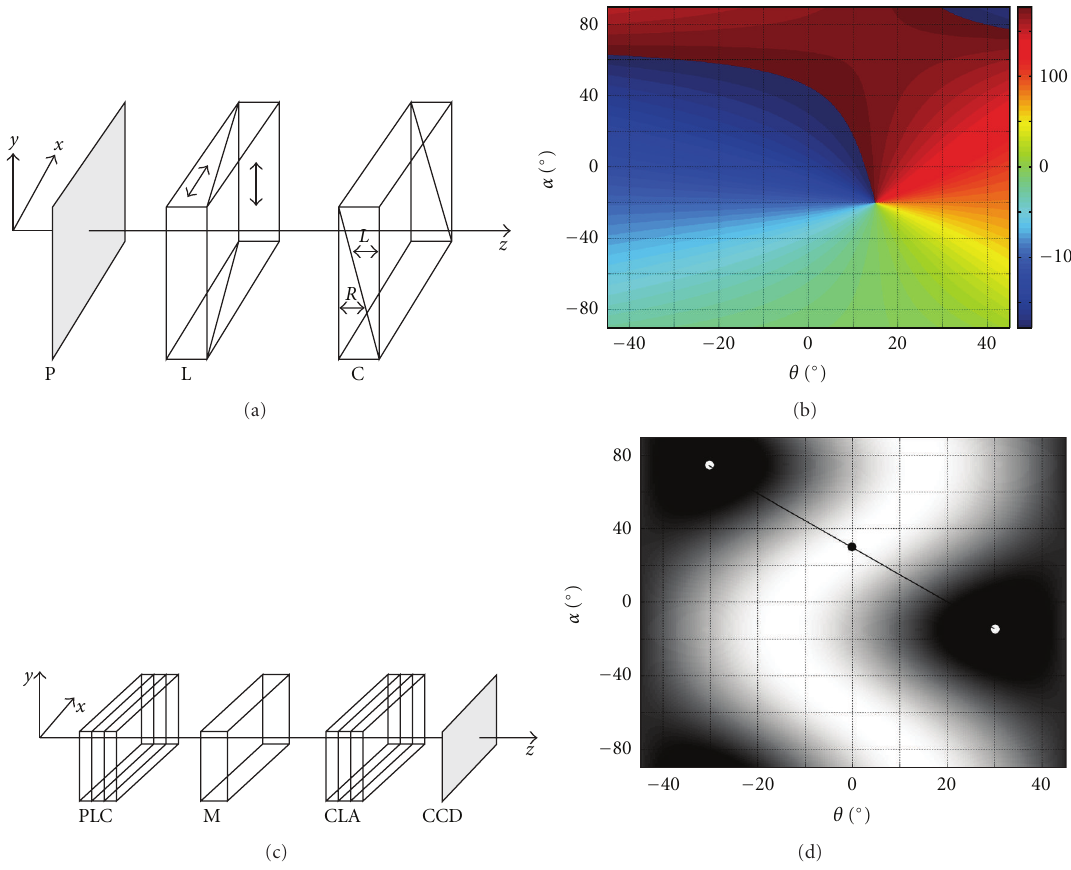
Figure 8: (a) A new polarimetric system consists of polarizer P, Wollaston prism L , and a circular wedge compensator C . This setup produces a table of all polarization states. When working in reverse direction (light incident on circular wedge compensator C ), the optical vortex appears as shown (as a phase map) in part (b). Having the position of this vortex point, it is easy to read the polarization state of the incident light; (c) a more complex system named “spatial elliptical polariscope”. Here M is a birefirngent medium under measurement. Figure (d) shows the intensity distribution with two dark points where optical vortices are seeded. Each vortex points (white points) indicate the state of the polarization of fast and slow beams, respectively. The black points show the position of maximum intensity. The distribution of these points enable determining the azimuth and ellipticity of both the beams and also the retardation between them [36].